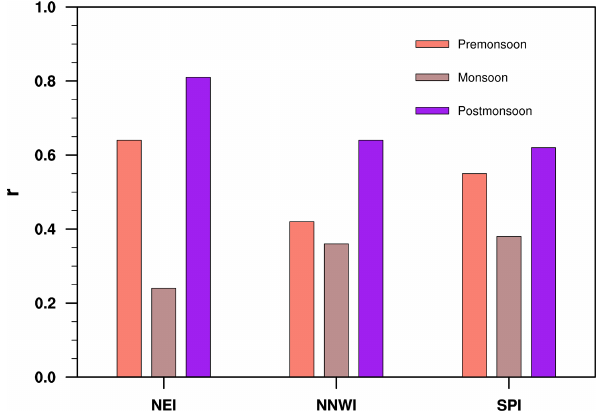
Figure 2. Pearson correlation coefficient (r) between LFD and graupel concentration over NEI, NNWI and SPI during premon- soon, monsoon and postmonsoon